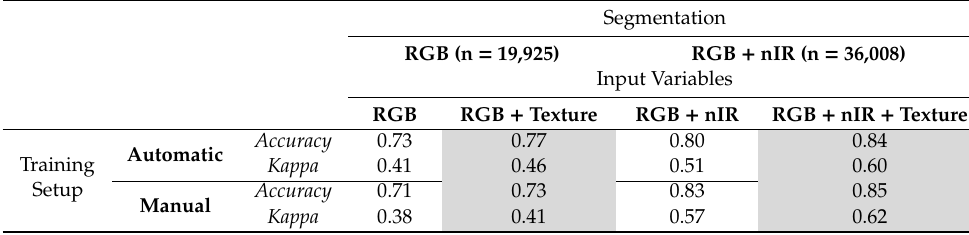
Table 2. Classification accuracies and kappa coefficient using different input variables and training setups.